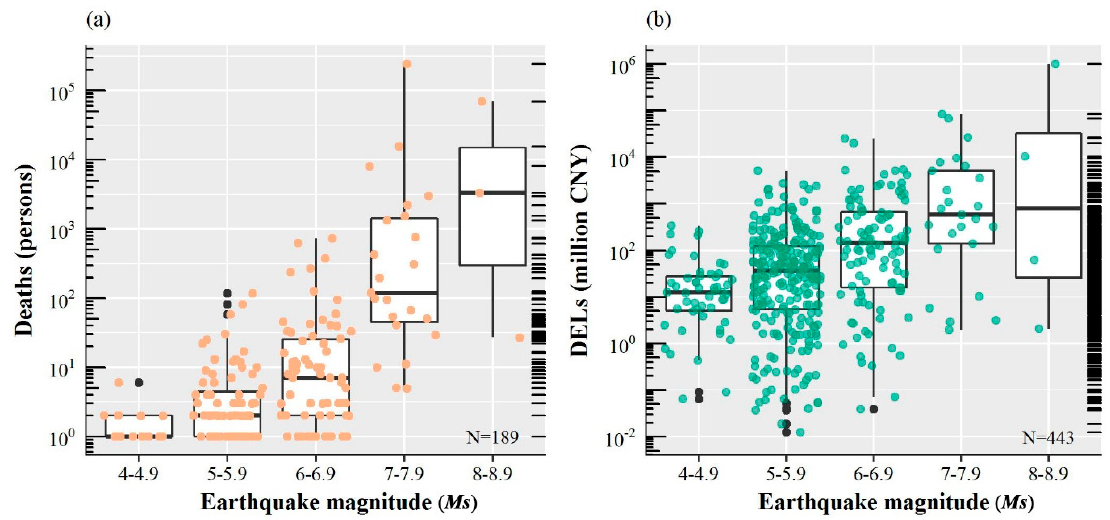
Figure 6. The relationship between Ms and earthquake-induced DELs ( a ) and deaths ( b ). The earthquake disasters plotted in the figures are associated with at least one death ( a ) or with reported DELs ( b ).